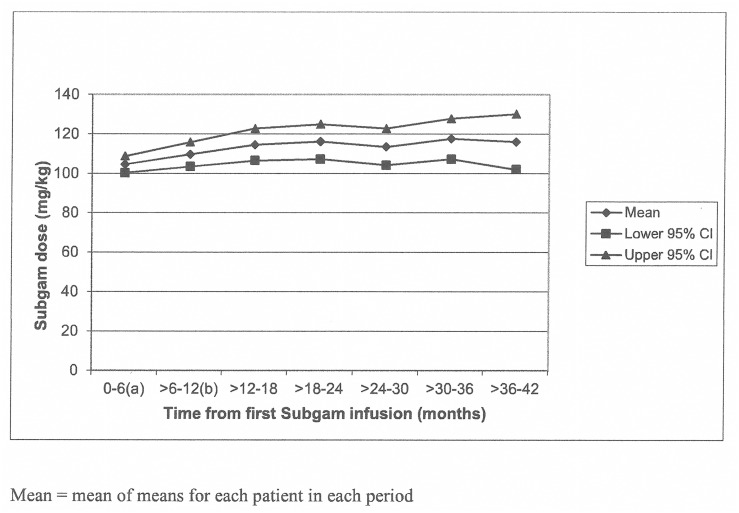
This is the graph showing Subgam dose per infusion (mg/kg) in 6-monthly intervals up to 42 months.